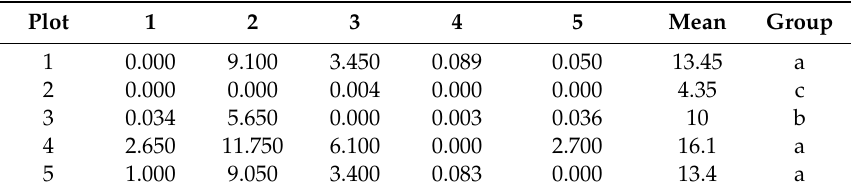
Table 6. Analysis of variance of the coverage of dead woody components of the five plots of the study Table 7. Tukey post hoc test— p -values results of the dead component coverage across the five plots of area. the study at